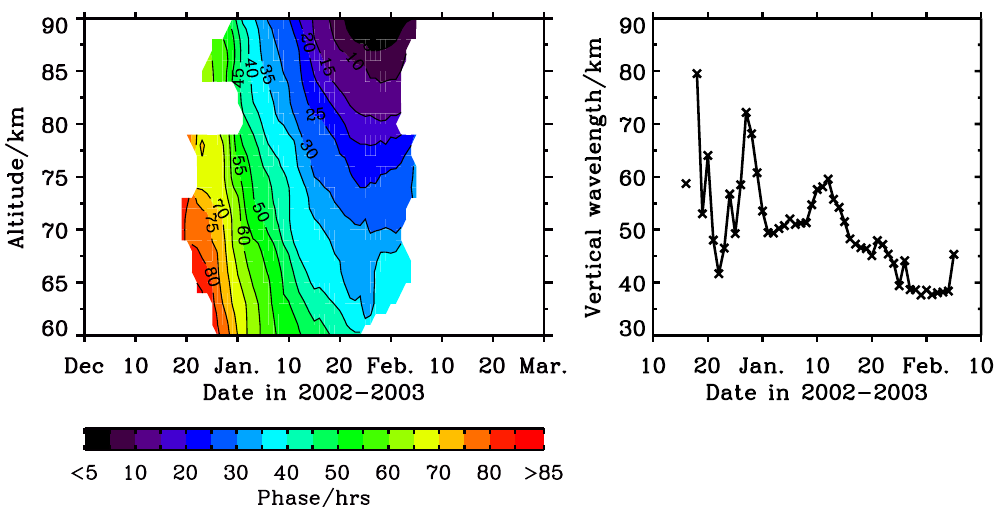
Fig. 4. Time–altitude variations of the phases of (2.13, W3) at 32 ◦ S (left) and day-to-day variations of its vertical wavelengths (right).